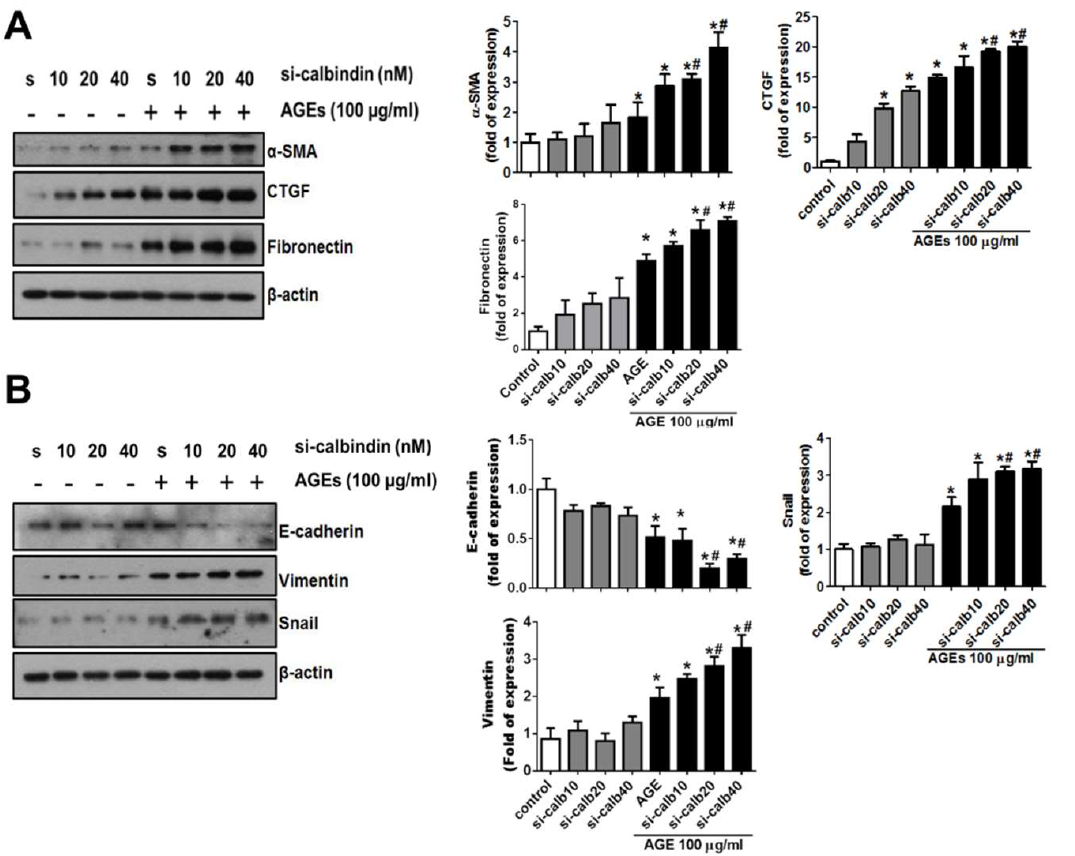
Figure 3. Calbindin-D28k silencing enhanced AGEs-induced fibrotic signals in HK2 cells. Cells were transfected with scramble (s or control; 40 nM) or calbindin-D28k siRNA (si-calbindin or si-calb10-40; 10–40 nM) for 6 h. Transfected cells were treated with or without AGEs (100 μg/mL) for 48 h. ( A ) Protein expressions of α-SMA, CTGF, and fibronectin were determined by Western blotting. ( B ) Protein expressions of E-cadherin, vimentin, and Snail were determined by Western blotting. Protein levels were quantified by densitometry and normalized by β-actin levels. Data are presented as means ± SEM (n = 5). * P < 0.05, vs. scramble control group. #P < 0.05, vs.